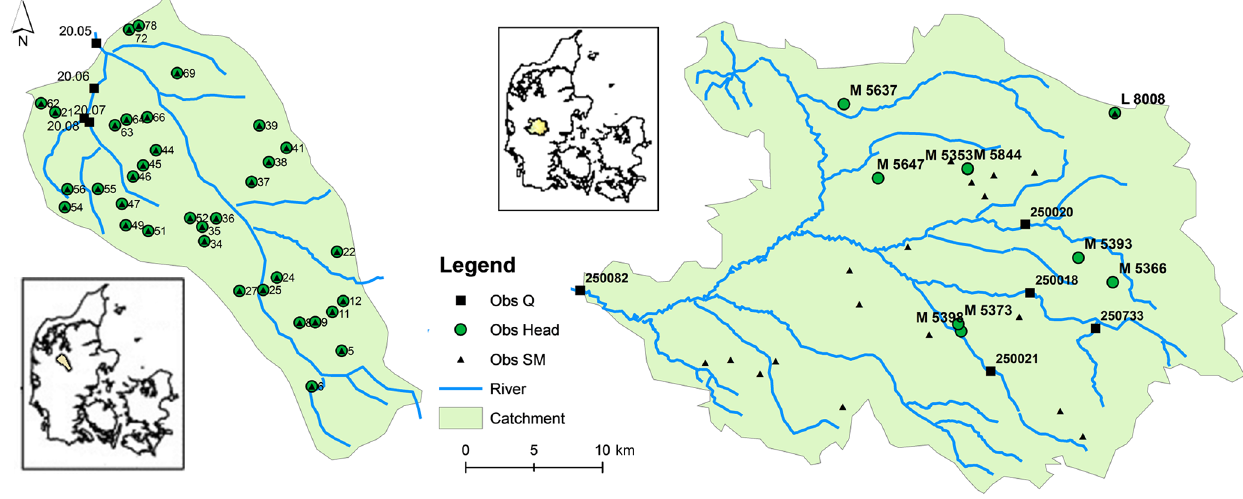
Figure 1. Left: Karup catchment; right: Ahlergaarde catchment. “Obs Q”, “Obs Head” and “Obs SM” represent discharge, groundwater head and soil moisture observations respectively used for